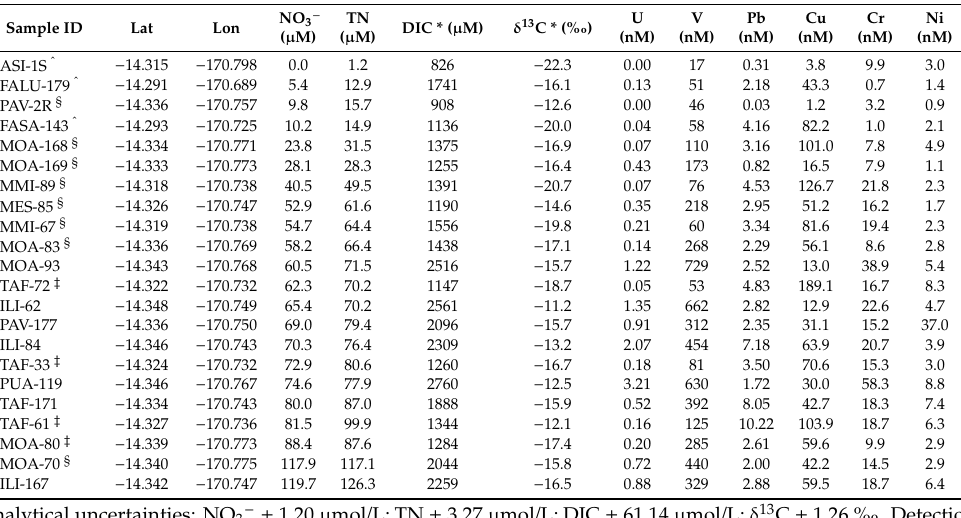
Figure 4. Scatterplots showing distribution and correlation between ( a ) NO 3 − and U, ( b ) NO 3 − and V, ( c ) dissolved inorganic carbon (DIC) and U, and ( d ) DIC and V. Samples collected within the Tafuna– Leone Plain are indicated by red circles. Samples collected north of the Tafuna–Leone Plain, therefore from a different volcanic series and aquifers, are indicated by orange squares. GUDI wells (groundwater under the direct influence of surface water) from within the Tafuna–Leone Plain are indicated by white triangles. Trend and significance values computed for non-GUDI samples. Data for all plots are in Table 1.